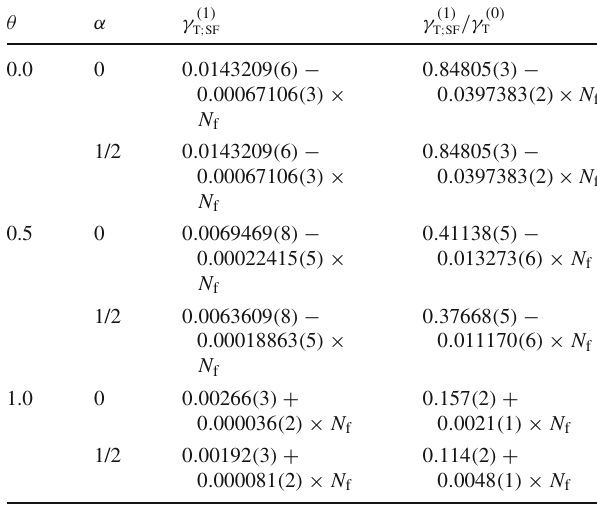
Table 2 NLO anomalous dimensions for various SF schemes, labeled by the parameters θ and α . The ratio to the LO anomalous dimension is also provided, as an indicator of the behaviour of the perturbative ( 1 ) /γ ( 0 ) = 0 . 1910 − 0 . 0091 × N expansion. For comparison, γ T T ; MS